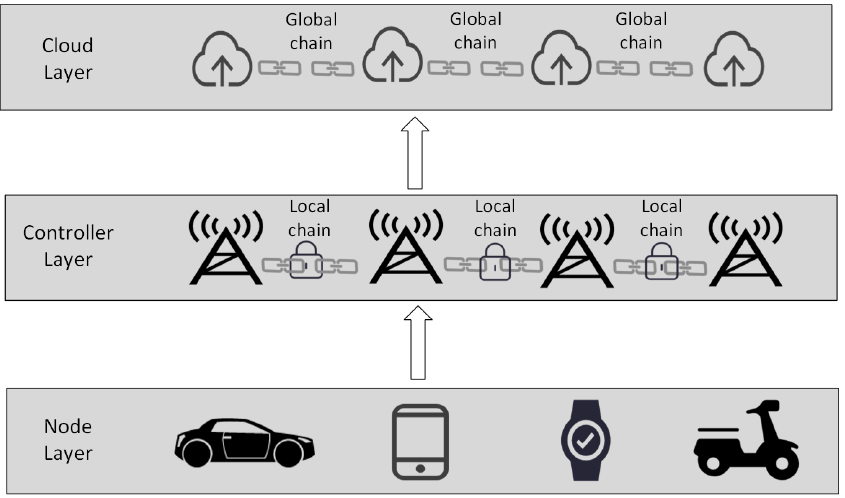
Figure 10. 3-layer structure of Game Theory-Based Authentication Framework to Secure Internet of Vehicles with Blockchain in